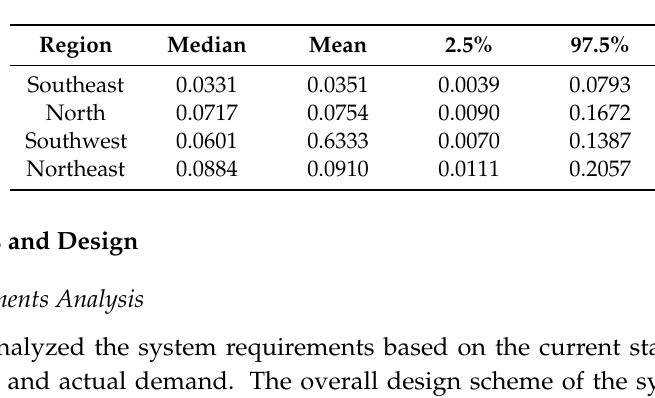
Table 9. The results of the model in di ff erent